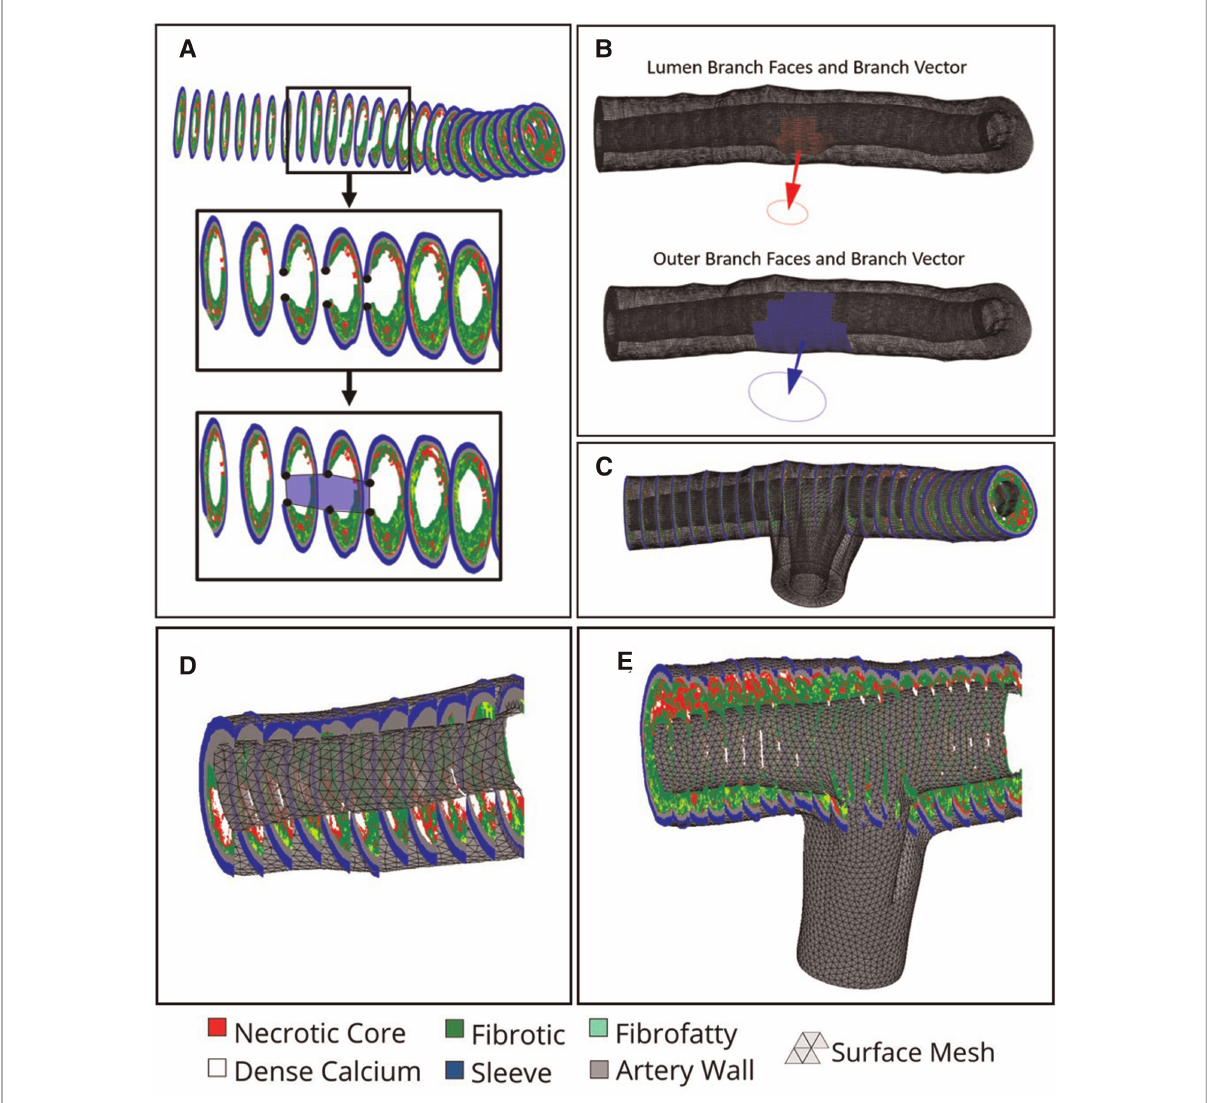
FIGURE 4 Branch creation procedure. ( A ) Black dots overlayed on VH-IVUS image represent the inner and outer coordinates proximal to the branch region in blue. ( B ) Computed Normal vectors to plan the branch lofting procedure. ( C ) Branched mesh post lofting procedure merged with main arterial mesh. ( D ) non-bifurcated and ( E ) bifurcated arterial meshes, respectively, after smoothing and resampling is